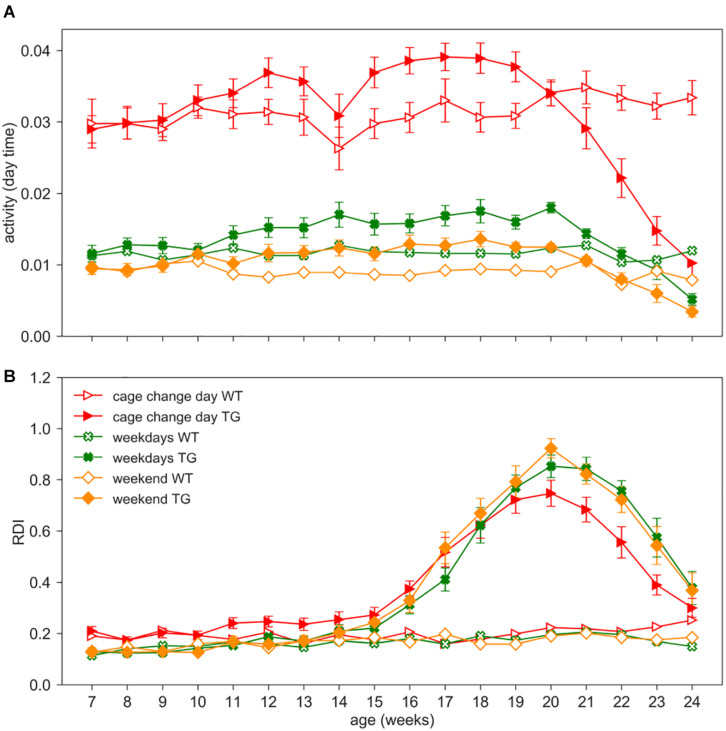
Impact of procedures. Day time activity (A) and RDI (B) curves across weeks 7–24 in WT (open symbols) and TG (filled symbols) (males and females) during cage change days (red triangles), weekdays (green crosses, 2 days in which procedures as grid test or body weight assessment were performed) or weekends (orange diamonds, Saturday and Sunday, without procedures). Data are mean ± SEM. N of cages per group: WT = 19; TG = 19. No differences were observed in RDI between weekdays and weekends in both genotypes. RDI is not influenced by personnel activity in the room nor by experimental procedures.